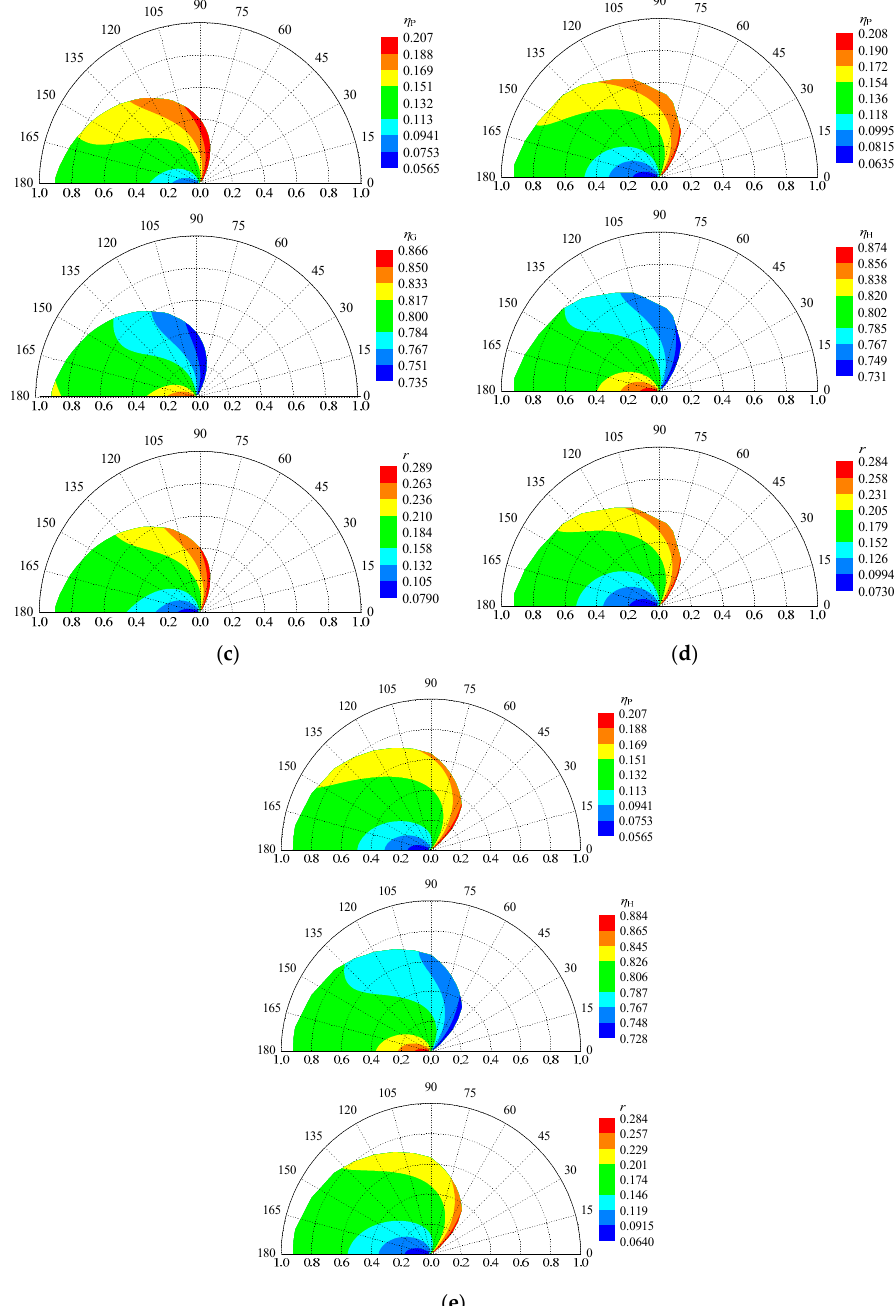
Figure 10. Results of the two efficiencies η and the power to heat ratio r for varied gap L , mirror opening angle Θ , and number of mirrors N in configuration 3. The radial axis, circumferential axis and color contour represent L , Θ , and the value of the results, respectively. ( a ) N = 2; ( b ) N = 4; ( c ) N = 6; ( d ) N = 8; ( e ) N = 10.